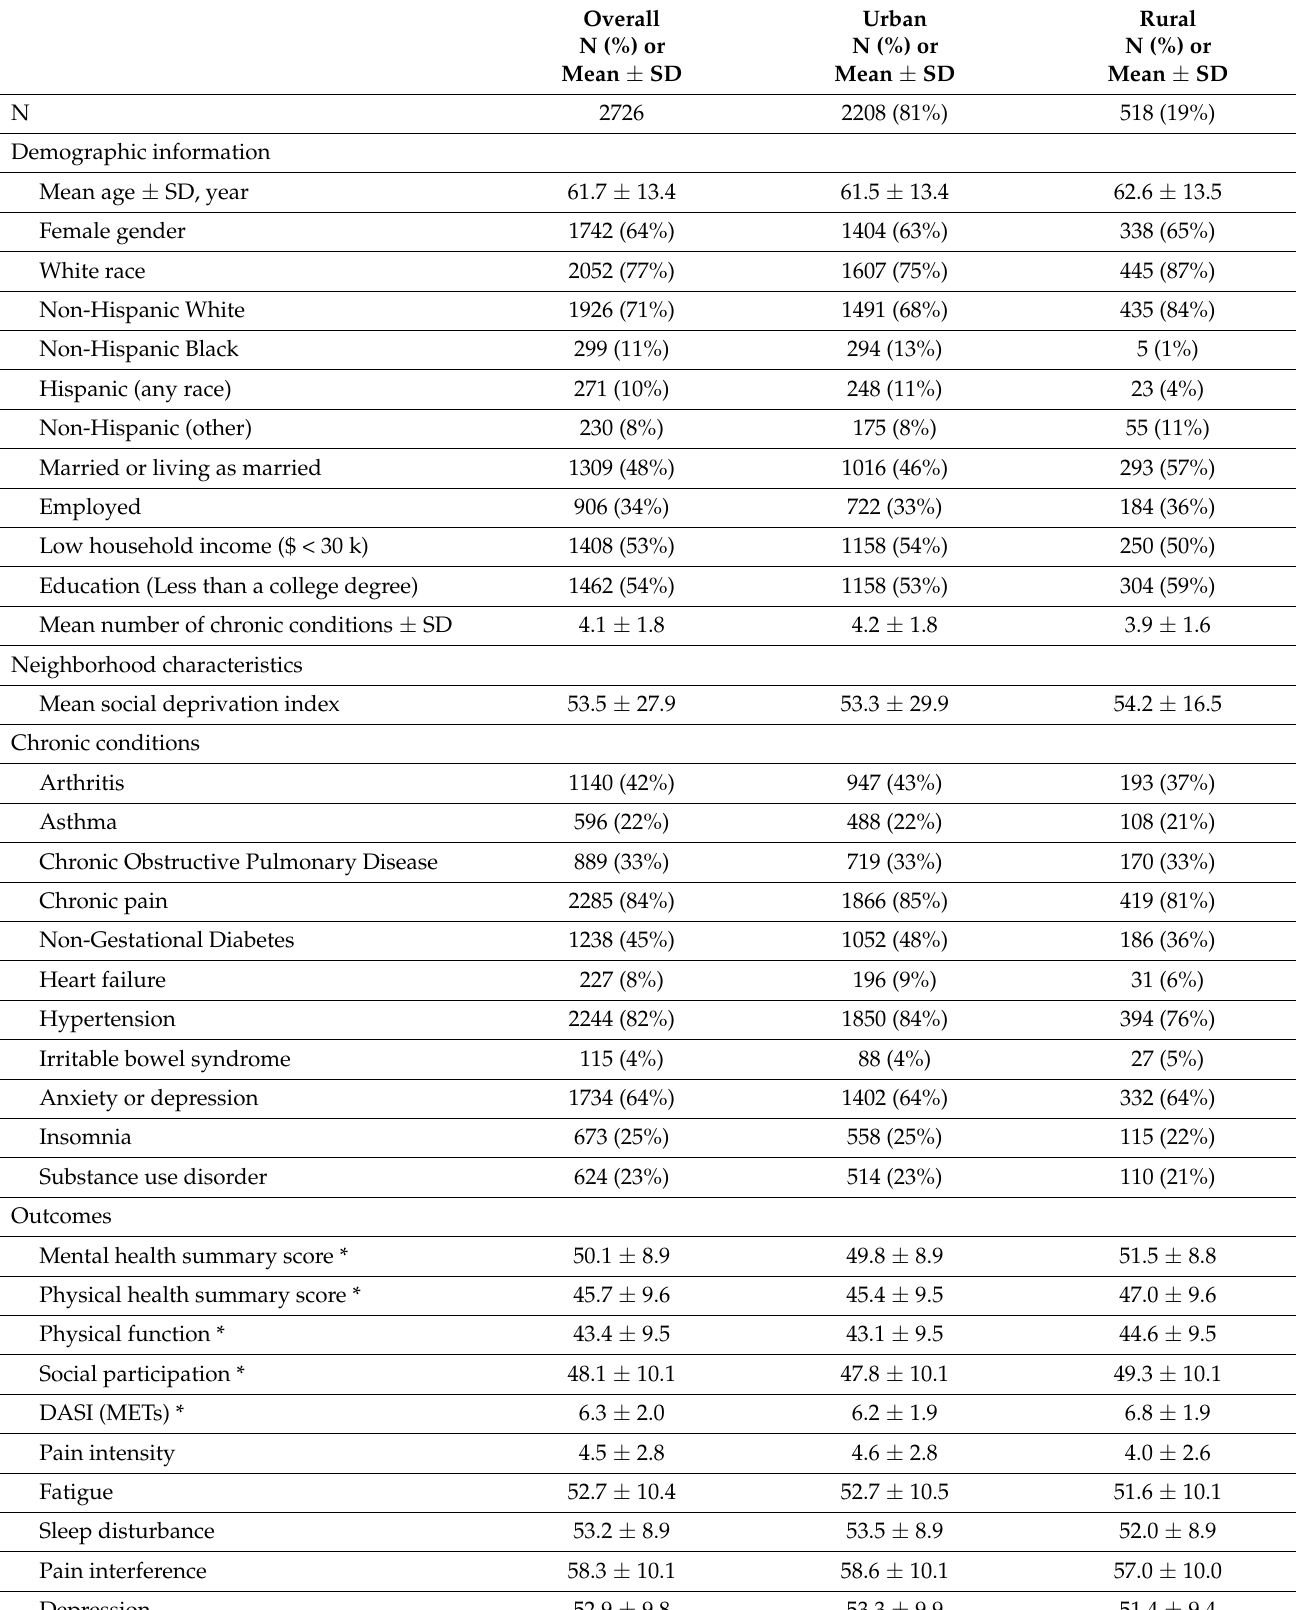
Table 2. Characteristics of the